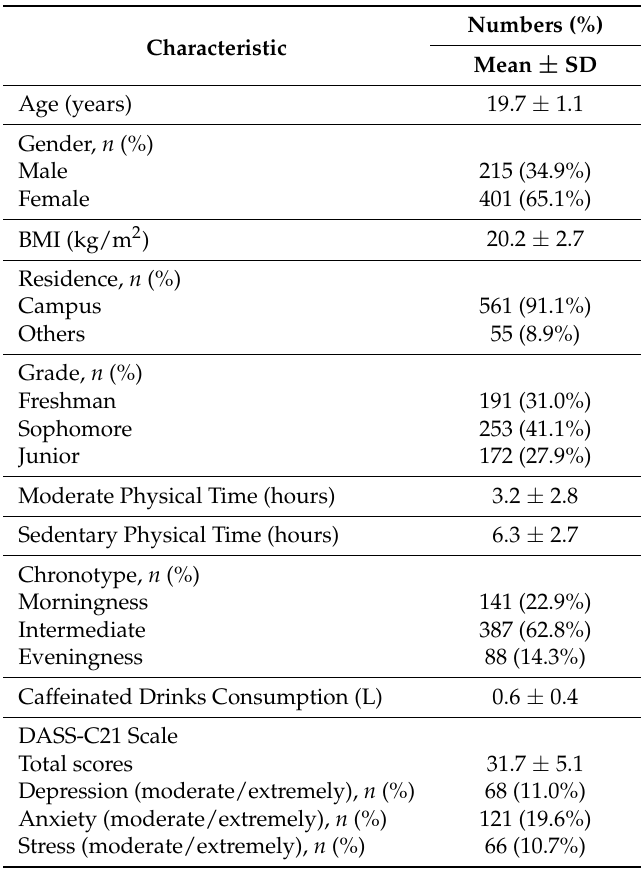
Table 1. Demographic Characteristics for the Total Sample ( n = 616).